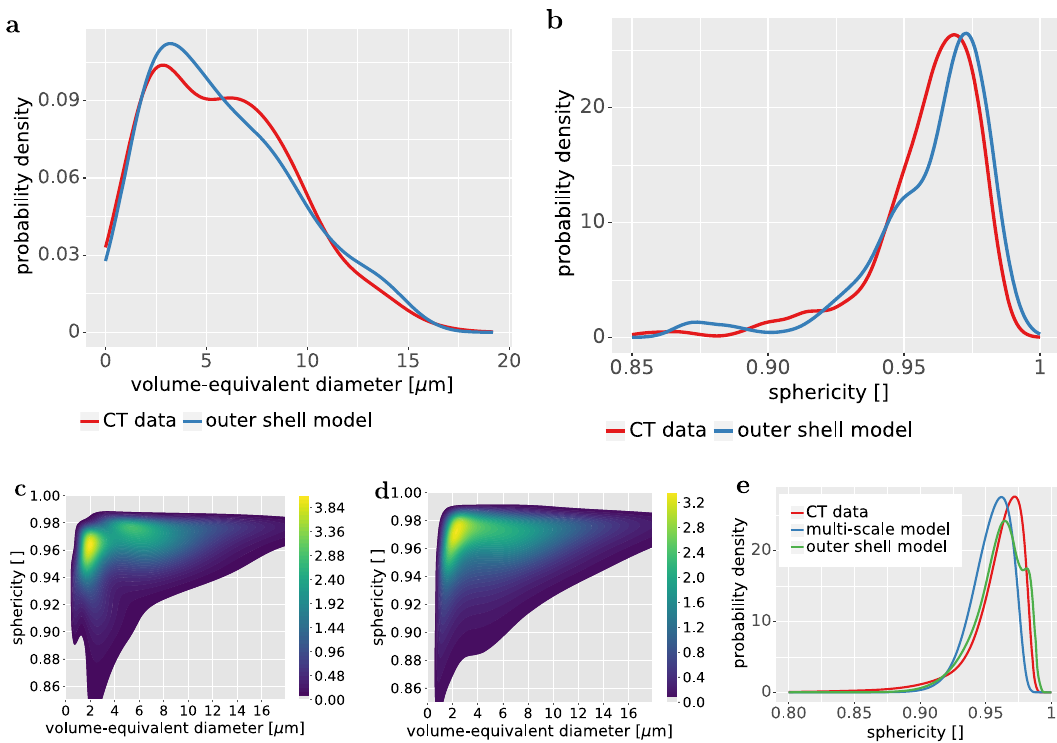
Fig. 7 Validation of the outer shell and multi-scale model. Probability densities of the volume-equivalent diameter ( a ) and sphericity ( b ) of particles observed in CT data (blue) and model realizations (red). Bivariate probability densities of the volume-equivalent diameter and sphericity of particles observed in CT data ( c ) and model realizations ( d ). The corresponding sphericity distributions under the condition that d = 7.44 μ m ( e